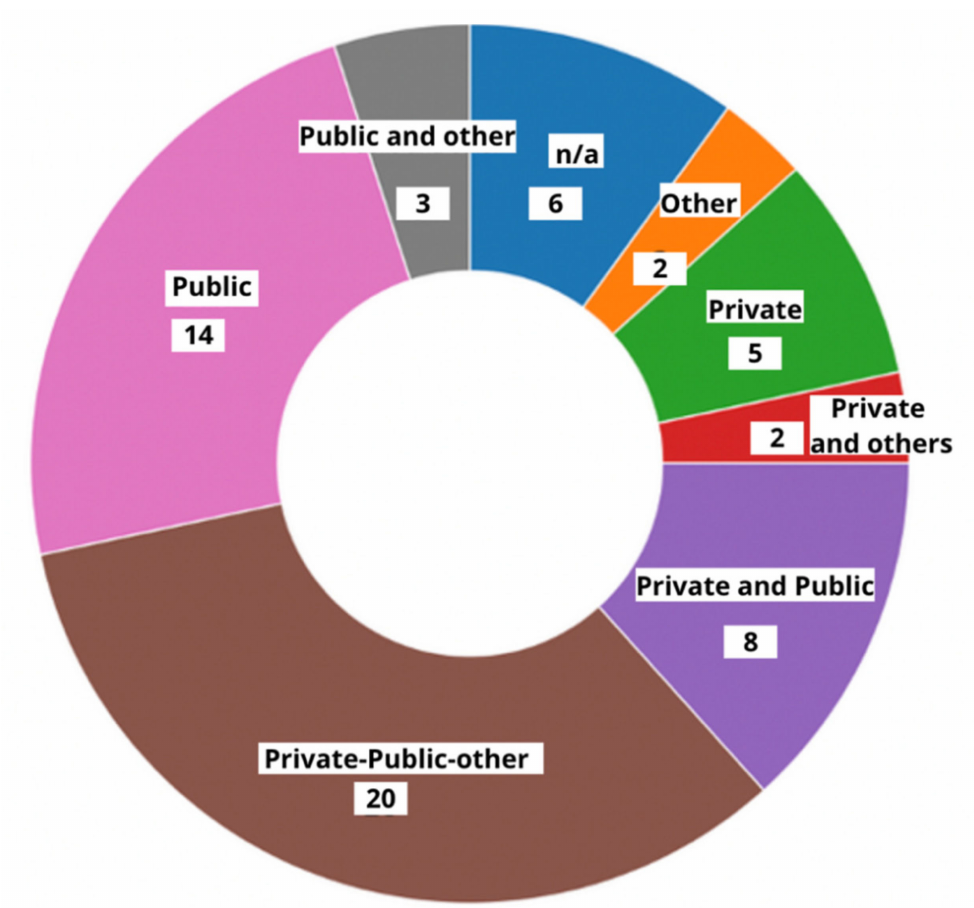
Figure 5. Commonly used type of finance